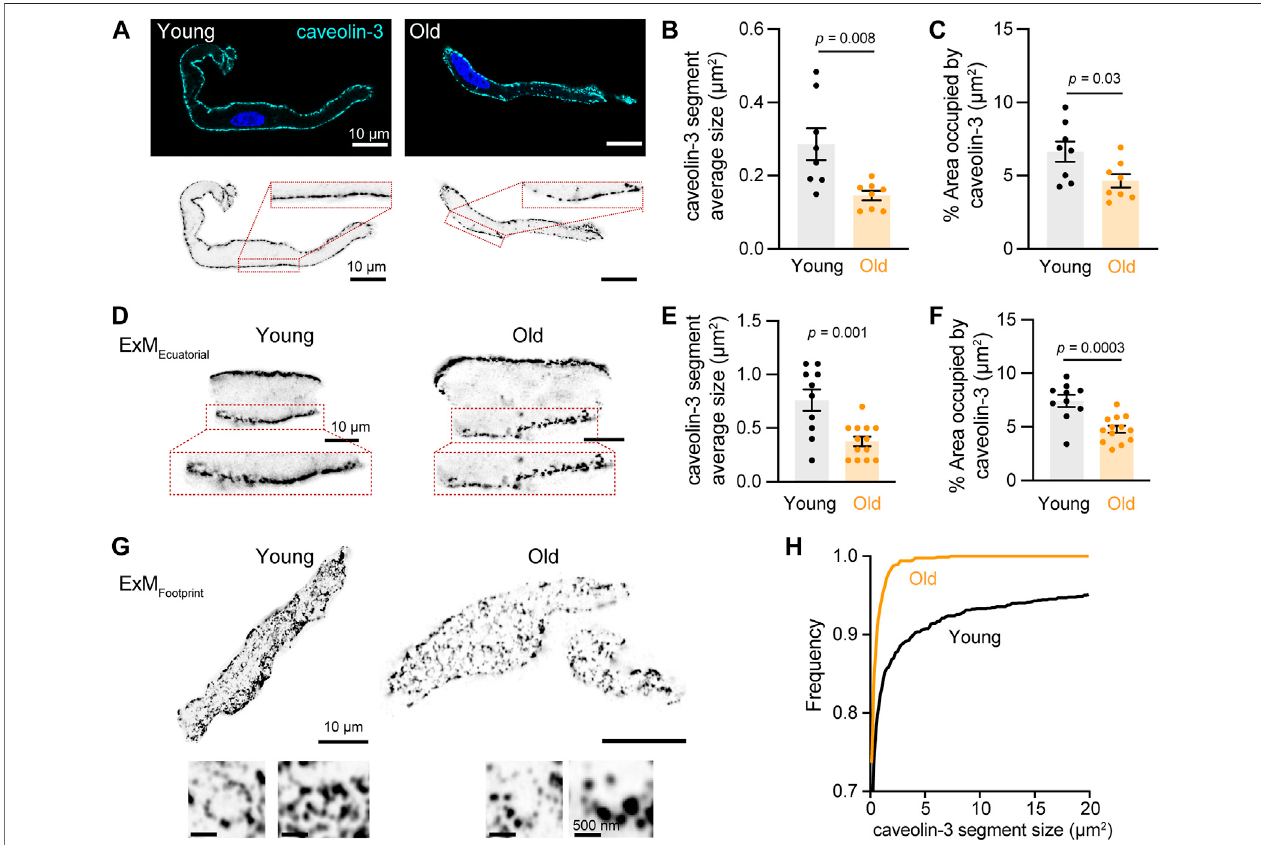
FIGURE 5 | Aging decreases the size and area occupied by caveolae. (A) Representative pictures of pacemaker cells labeled with antibody anti-caveolin-3 (cyan) and counterstained with DAPI to visualize the nucleus (blue). Same pictures in grayscale and inverted are shown at the bottom. (B) Comparison of the average segment size positive for caveolin-3 between young (n = 8, N = 3 mice) and old (n = 8, N = 3 mice) cells. (C) Comparison of percent area occupied by caveolin-3 structures betweenyoung(n=8,N=3mice)andold(n=8,N=3mice)cells. (D) Representativepicturesofpacemakercellsexpandedtoimprovetheresolutionofcaveolin-3 segments.Onlyaregionofthecellisshown. (E) Comparisonoftheaveragesegmentsizepositiveforcaveolin-3betweenexpandedyoung(n=10,N=3mice)andold(n = 13, N = 3 mice) cells. (F) Comparison of percent area occupied by caveolin-3 structures between expanded young (n = 10, N = 3 mice) and old (n = 13, N = 3 mice) cells. Note a 2.5-fold increase in segment size between expanded and not expanded cells. Statistical comparison used an unpaired t-test with signi fi cance at p < 0.05. (G) Representative pictures of the footprint of expanded young and old pacemaker cells labeled with anti-caveolin-3. (H) Comparison of the cumulative frequency distribution of the size of caveolin-3 segments from expanded young (black, n = 10, N = 3 mice) and old (orange, n = 13, N = 3 mice) cells.